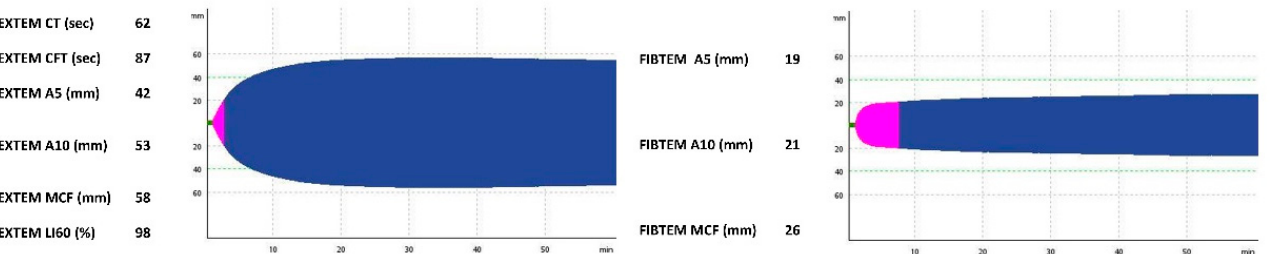
Figure 7. Hemostatic profile of patient on the day of clinical deterioration, as depicted by ROTEM EXTEM and FIBTEM graphic representation and numerical results. Abbreviations: CT, clotting time (min, green colour); CFT, clot formation time (min, pink colour); A5 and A10, clot amplitude at 5 and 10 min (mm); MCF: maximum clot firmness (mm, blue colour); LI60, lysis index at 60 min (%).